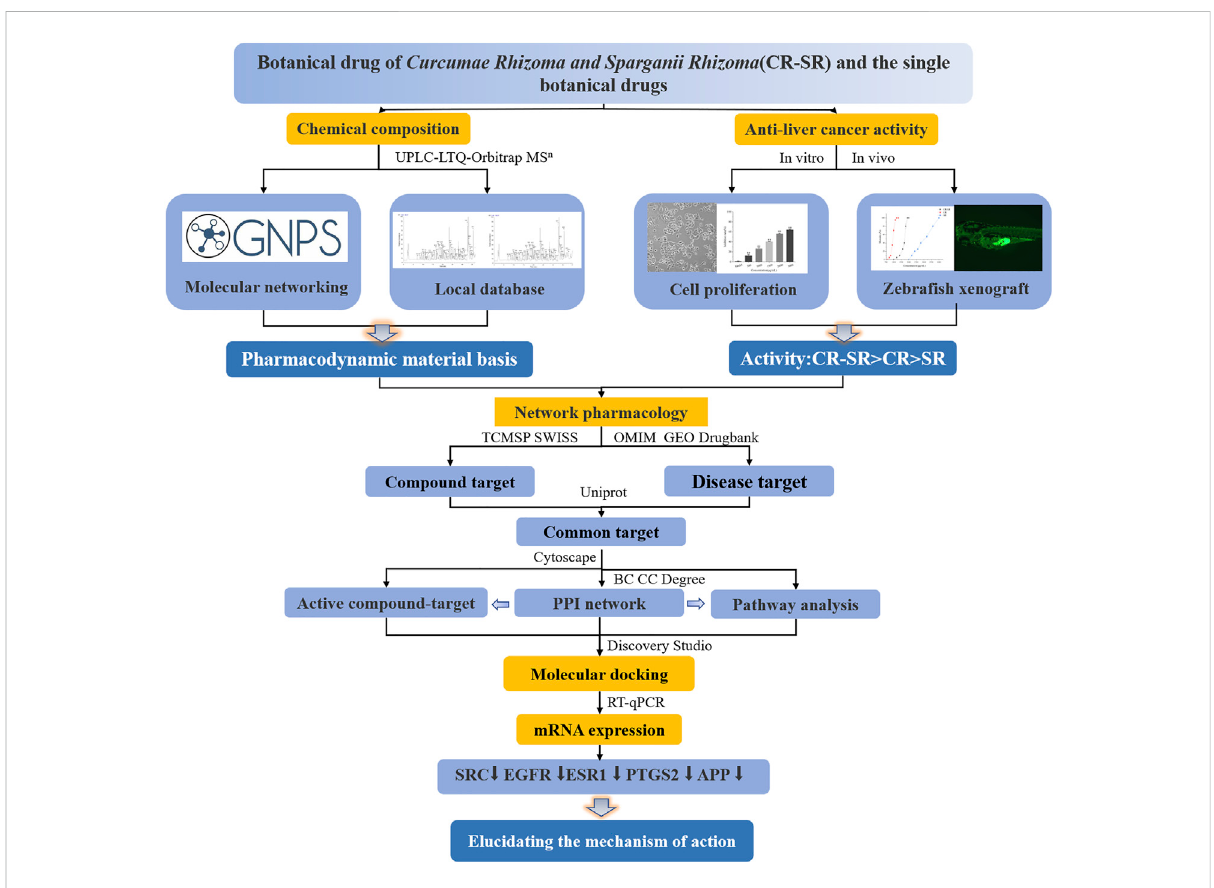
FIGURE 1 Flow chart of the study